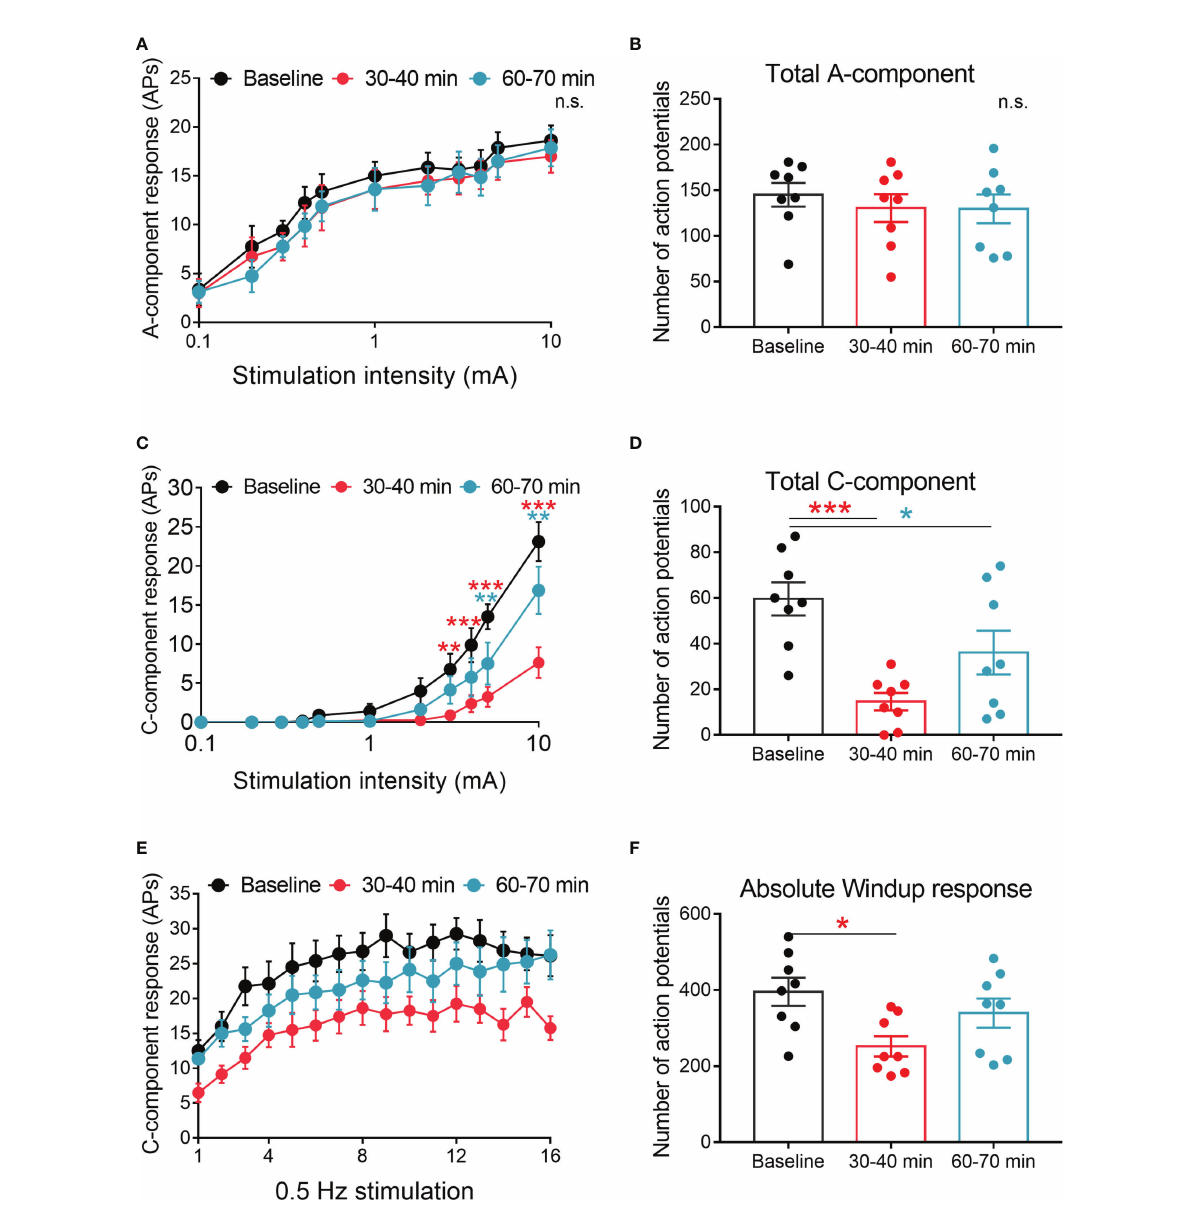
FIGURE 5 Spinal 4-OI attenuated the C-component and windup responses of WDR neurons in CCI mice. (A) The stimulus-response functions of A- component to graded electrical stimulation before, 30-40 and 60-70 minutes after spinal 4-OI (100 m M, 10 m l). (B) The total number of action potentials (APs) in the A-component produced in response to graded electrical stimuli. (C) The stimulus-response functions of C-component before, 30-40 and 60-70 minutes after 4-OI. (D) The total APs of C-component produced in response to graded electrical stimuli. (E) Windup function in WDR neurons was examined before, 30-40 and 60-70 minutes after 4-OI. (F) The total number of C-components evoked by windup-inducing stimulation after 4-OI. n = 8/group; Data are presented as mean ± SEM. * p < 0.05, ** p < 0.01, *** p < 0.001 vs baseline by two-way ANOVA with Tukey ’ s multiple comparisons test (A, C, E) and paired t-test (B, D, F) . n.s., no signi fi